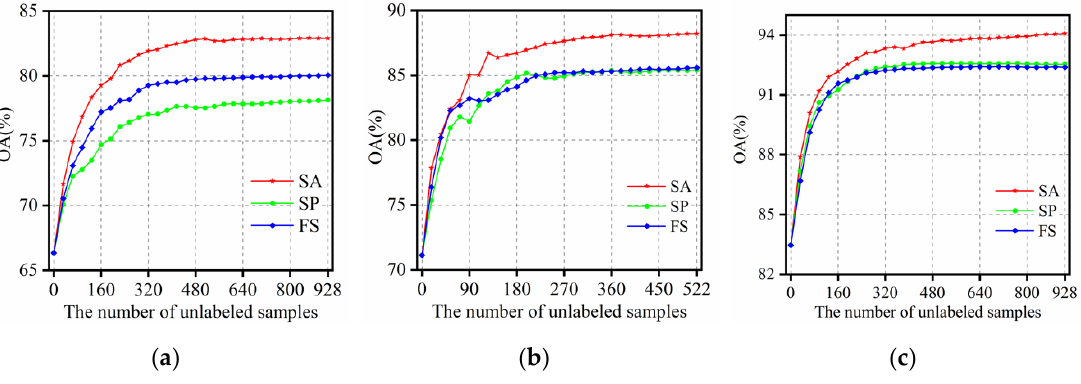
Figure 8. Overall accuracies (OAs) as a function of the number of unlabeled samples with unlabeled samples selected from the SA-, SP-, and FS- based neighborhood for the three datasets: ( a ) Indian Pines dataset; ( b ) Pavia University dataset; and, ( c ) Salinas Valley dataset.